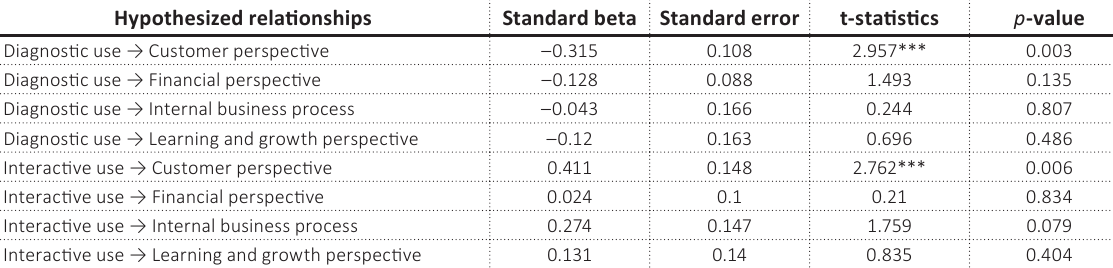
Table 5. Path coefficients for nature of use and organizational